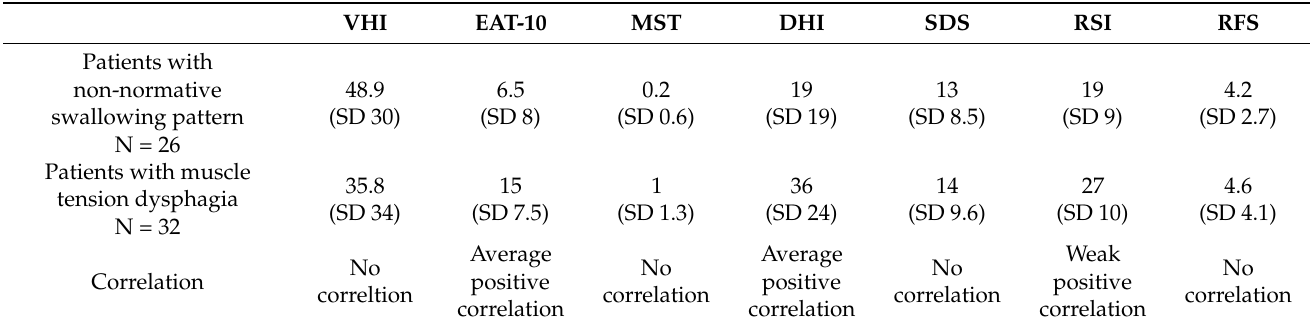
Table 1. Mean values of scores obtained from the questionnaires in subsequent patient groups. Pearson correlation of the questionnaires with the group type is shown. VHI EAT-10 MST